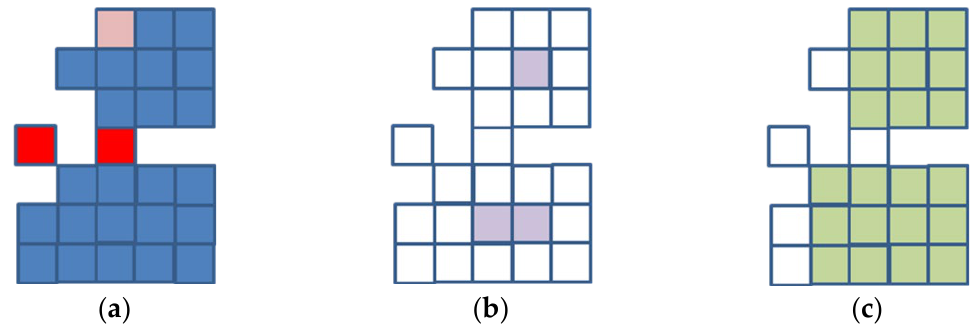
Figure 6. An example of deleting isolated points using chain codes. ( a ) The input. The pink grid is the start pixel of chain code tracing. ( b ) An erosion result of ( a ). ( c ) A dilation result of ( b ).